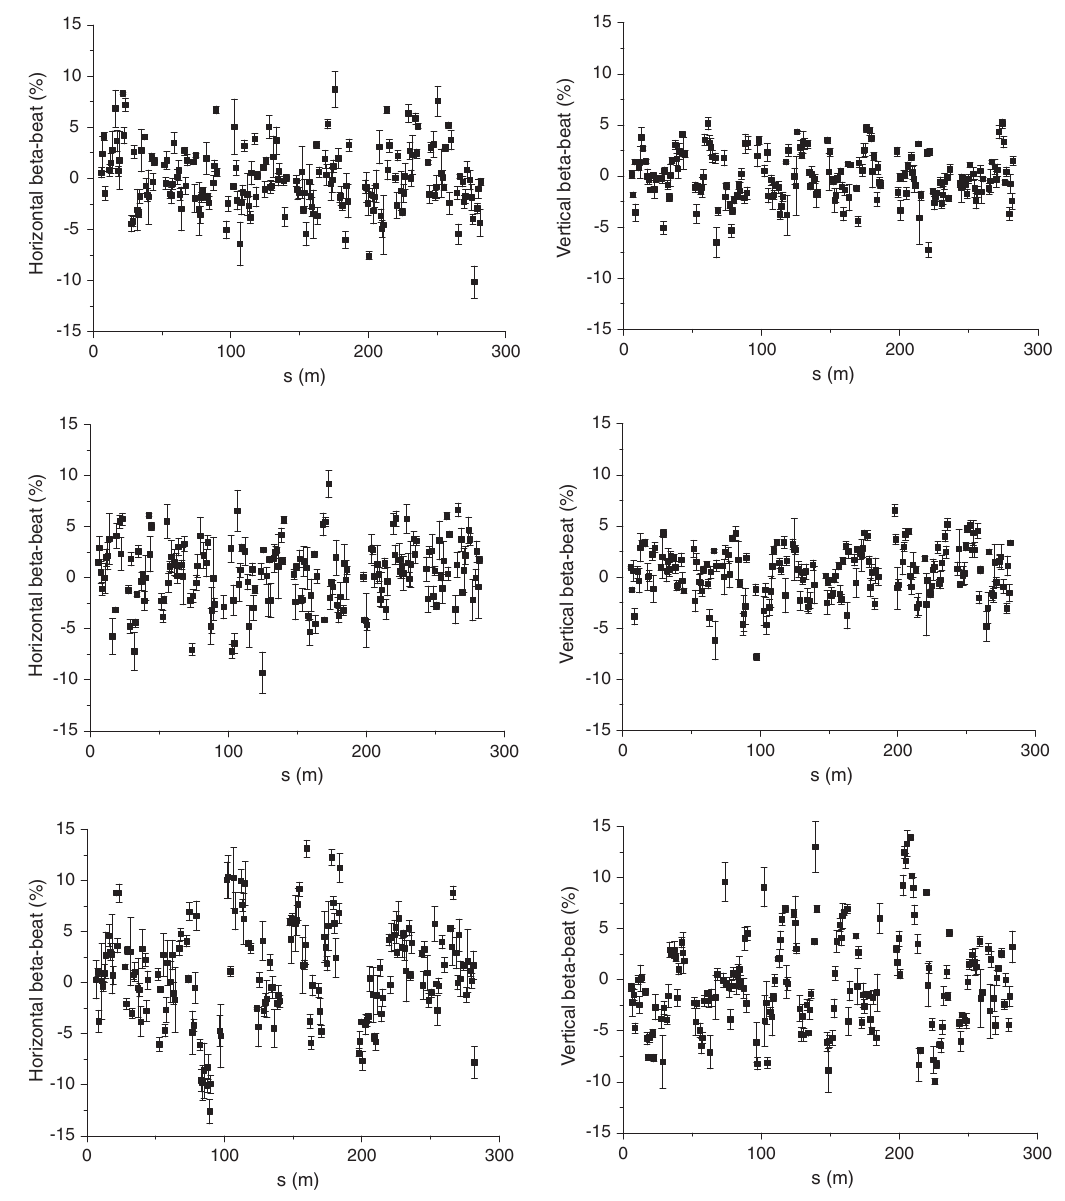
FIG. 12. A comparison of corrected optics. QV measurements for the optics corrected by QV (top), LOCO (middle), and TBT (bottom). With the offset subtracted, the horizontal and vertical beta-beats in rms are, respectively, 3.1% and 2.3% in QV, 3.2% and 2.5% in LOCO, and 5.1% and 4.8% in